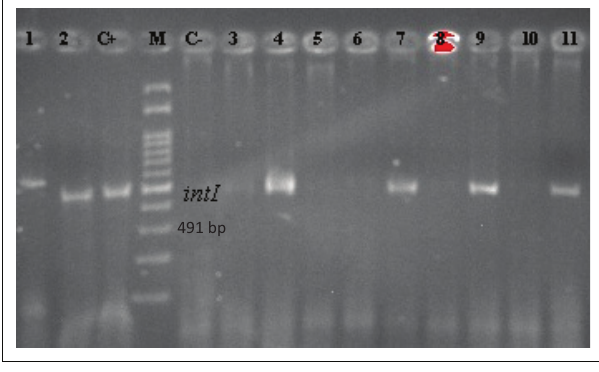
FIGURE 4: Polymerase chain reaction amplicons of Shiga toxin-producing Escherichia coli integrons. Polymerase chain reaction amplification of the class 1 integron, integrase. bp, base pair; int1 , integrase